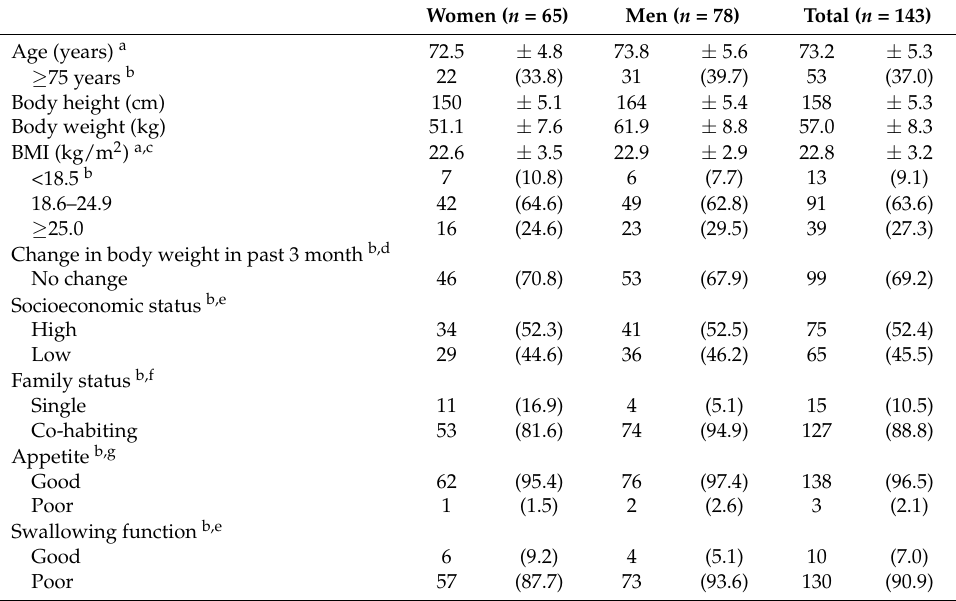
Table 1. Characteristics of study participants according to